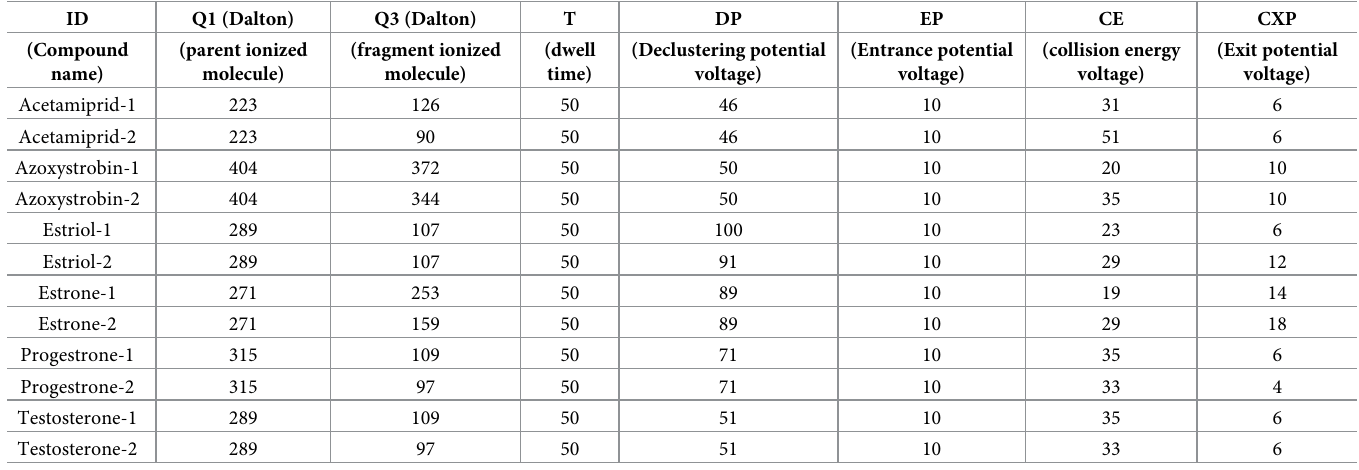
Table 2. Mass parameters of parent and daughter ions of pesticides and hormones on LC-MS/MS (n =